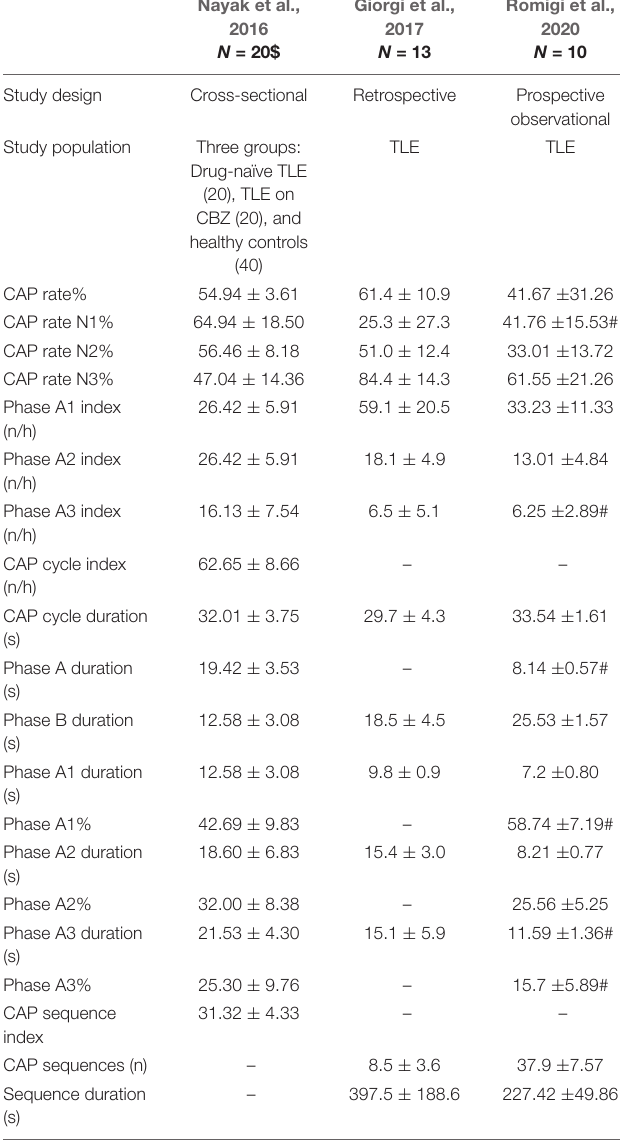
TABLE 5 | Studies assessing sleep microarchitecture in